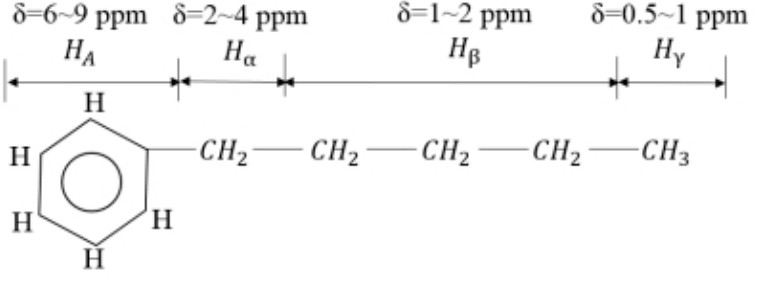
Figure 1. Assignments for 1 H chemical shifts.